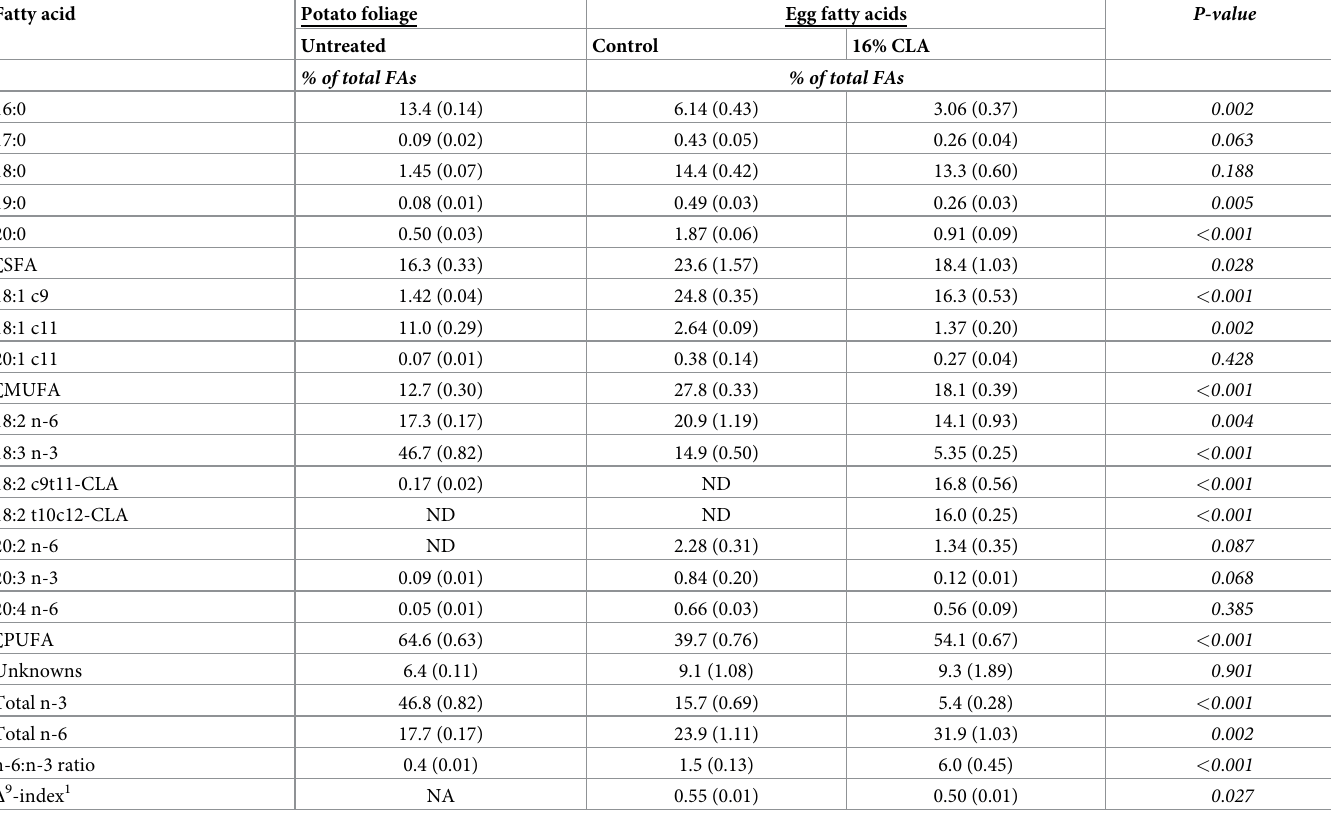
Table 2. Fatty acid composition in potato foliage and L . decemlineata eggs resulting from adult feeding assay .